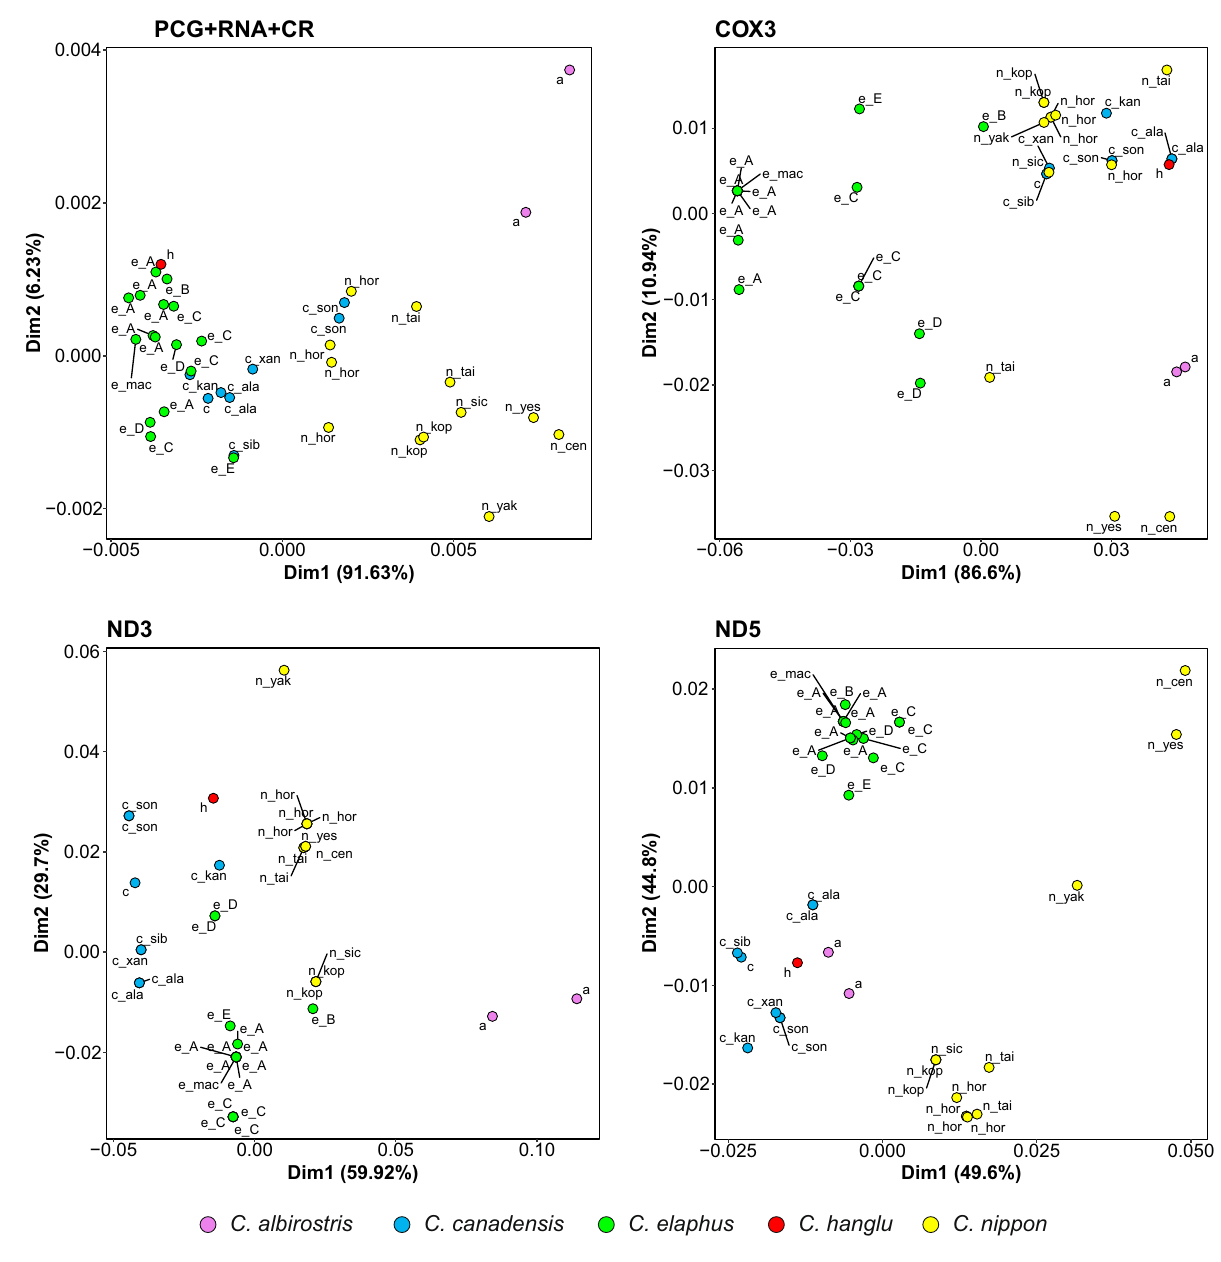
Figure 2. Correspondence analysis plots obtained for the nucleotide composition of 13 protein-coding genes (PCG), RNA genes and control region (CR) as well as selected PCG from various Cervus taxa: a— C. albirostris ; c— C. canadensis ; c_ala— C. canadensis alashanicus ; c_kan— C. canadensis kansuensis ; c_sib— C. canadensis sibiricus ; c_son— C. canadensis songaricus ; c_xan— C. canadensis xanthopygus ; e_A— C. elaphus